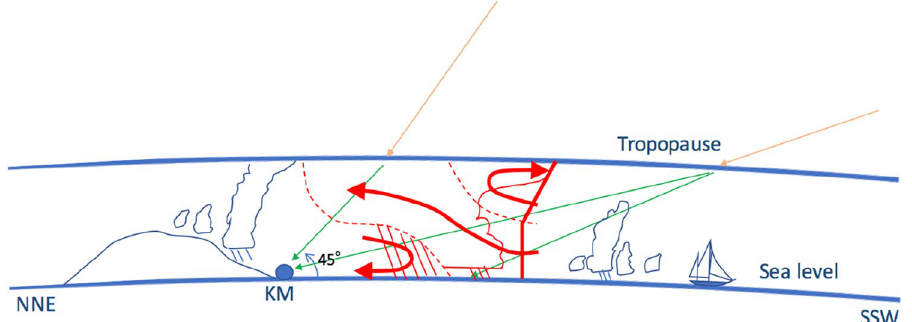
Figure 5. Schematic view of atmospheric muography conducted in this work. Orange and green arrows indicate the galactic cosmic rays (GCRs) and muons, respectively (a single GCR particle can generate numerous muons). The label "KM" indicates the location of the Kagoshima Muograph. A schematic diagram (red dashed lines and arrows) showing the airflow relative to a two-dimensional, steady-state MCS 49 is also overlaid. HKMT drew the image with Microsoft PowerPoint software and holds the copyright.